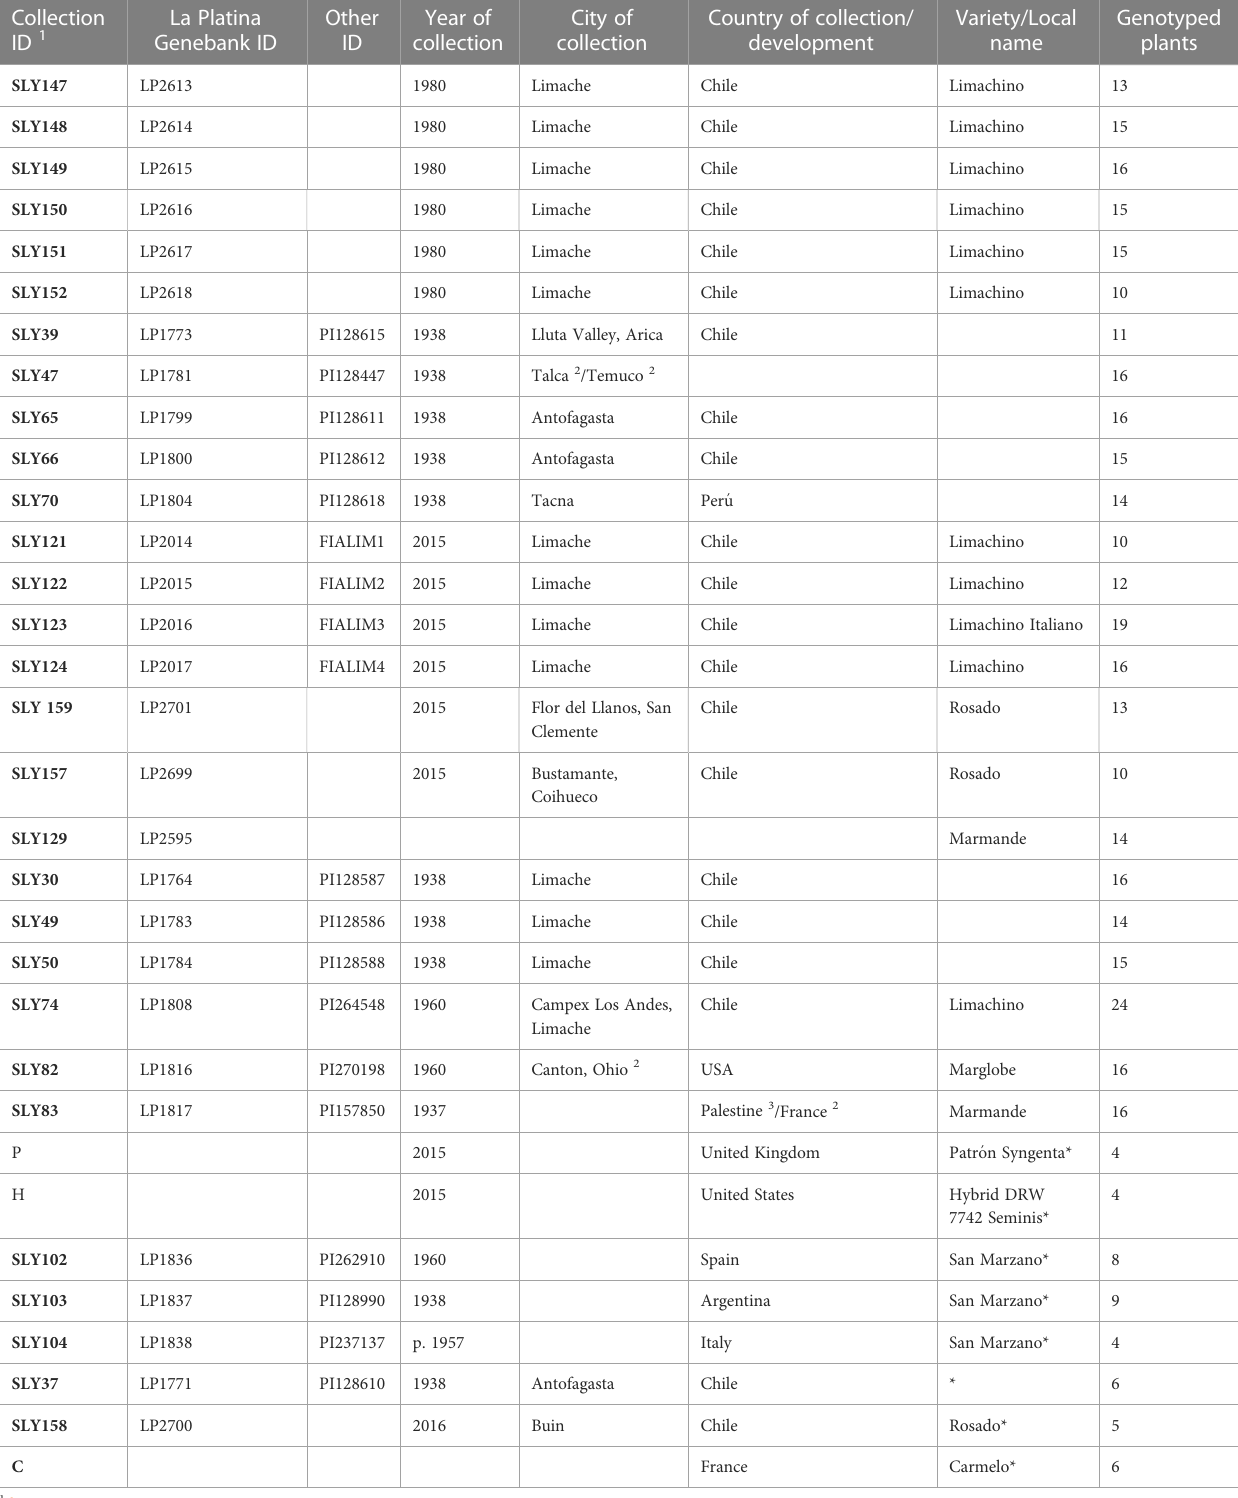
TABLE 1 Information on the accessions evaluated in this